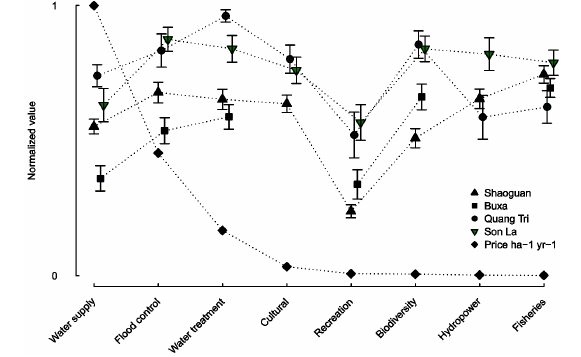
Fig. 2 . Normalized scores and standard error of ecosystem services of mean stakeholder perception values from four sites in Asia, and normalized mean monetary valuation. Lines have been added to help visualize the differences in rank of the services within each site, compared to the monetary valuation.